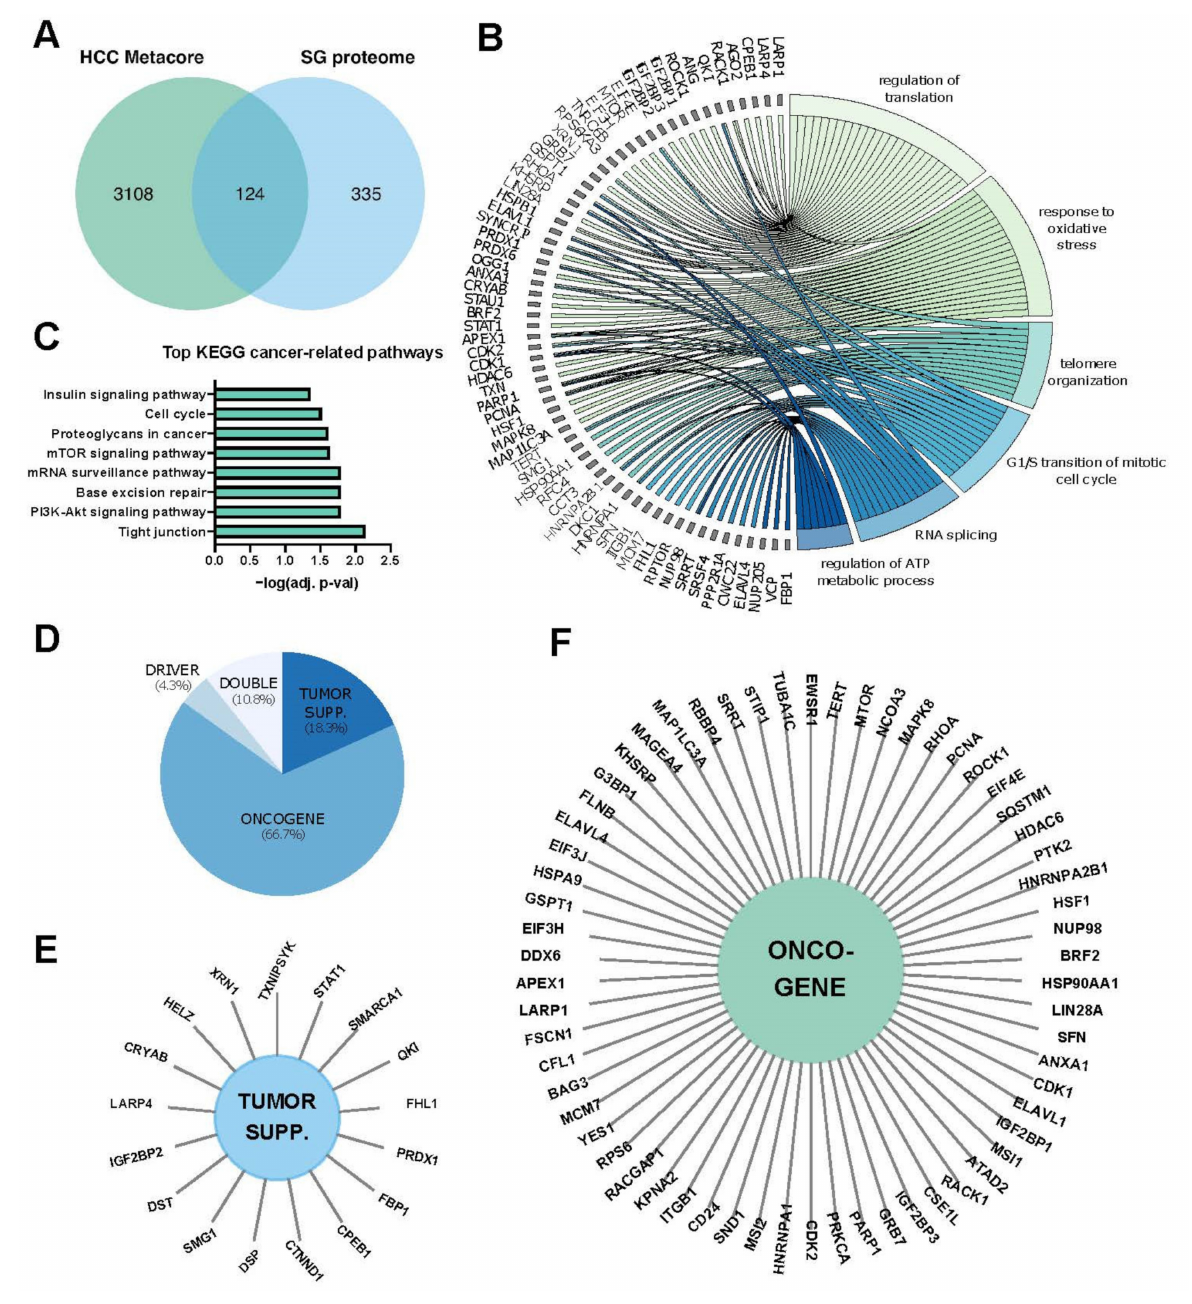
Figure 1. The SG proteome. ( A ) The stress granule (SG) proteome (https://msgp.pt/, accessed on 1 April 2021) was crossed with genes associated with hepatocellular carcinoma (HCC) obtained with the Metacore database (https://portal.genego. com/, accessed on 1 April 2021). ( B ) Gene ontology (GO) enrichment for biological processes (BP), with a cutoff of adjusted p -value at 0.05 was performed on the 124 genes found in ( A ). A chord-plot highlighting the most relevant processes and genes was constructed using the GOplot R package [24]. ( C ) KEGG pathway enrichment of 124 genes at a cut-off of 0.05 of the adj. p -value. ( D ) Annotation of cancer functions of the 124 genes using CancerMine [25]. ( E , F ), Sun diagrams showing annotated tumor suppressors ( E ) and oncogenes ( F